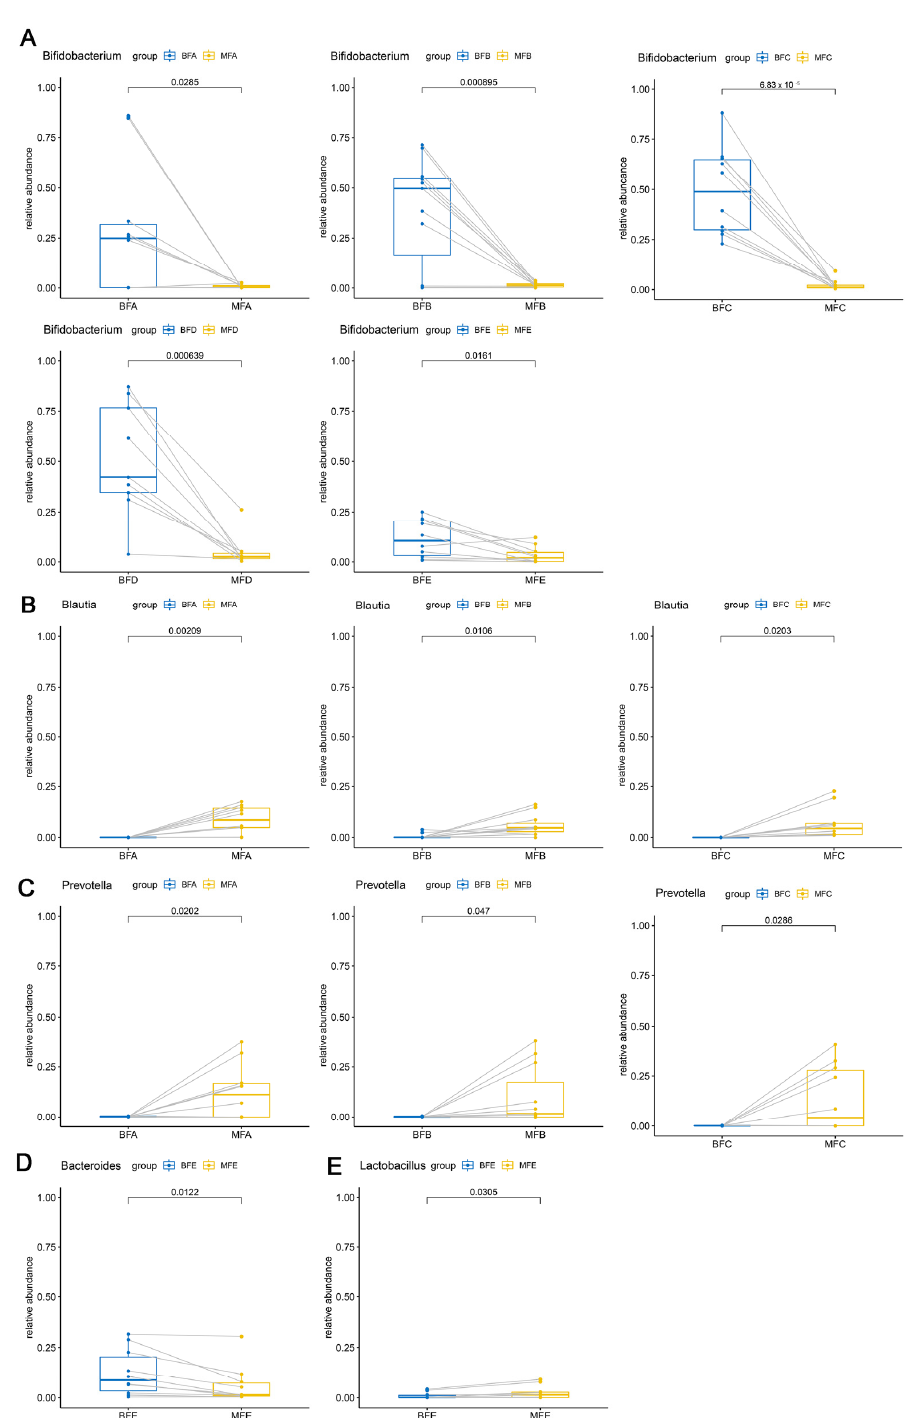
Figure 5. Different genera in maternal and infant feces. ( A – E ) stand for significant difference of Bifidobacterium , Blautia , Prevotella , Bacteroides , and Lactobacillus in maternal and infant feces, respectively. The two points connected by a line are the same mother-infant pair. MFA: maternal feces (corresponding to infant younger than one month of age), MFB: maternal feces (corresponding to infant between one and three months of age), MFC: maternal feces (corresponding to infant